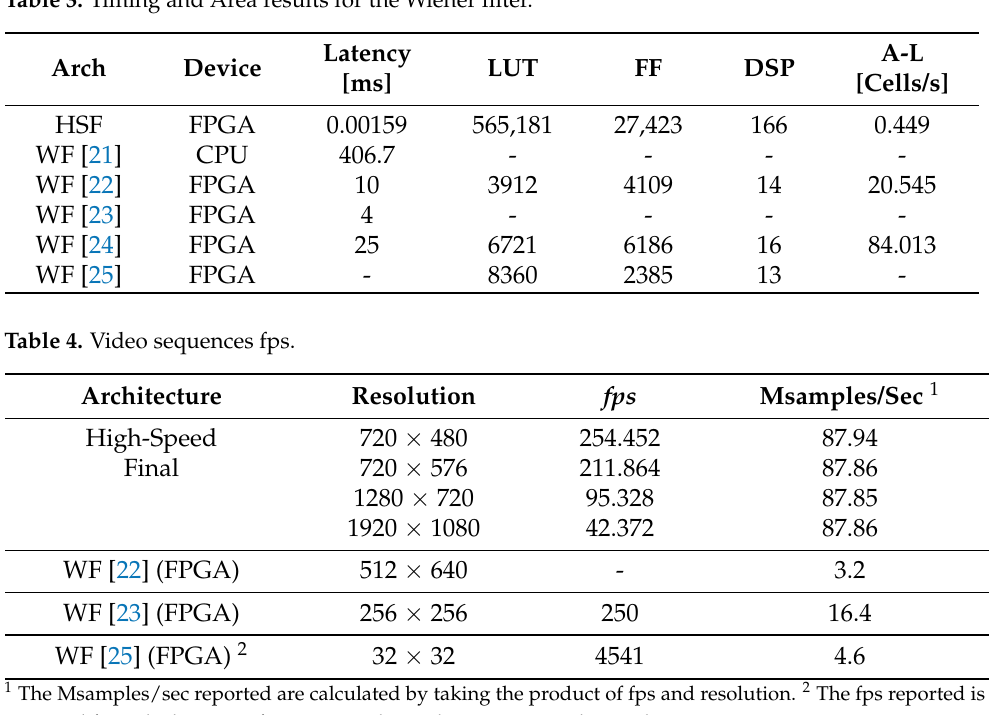
Table 3. Timing and Area results for the Wiener filter.